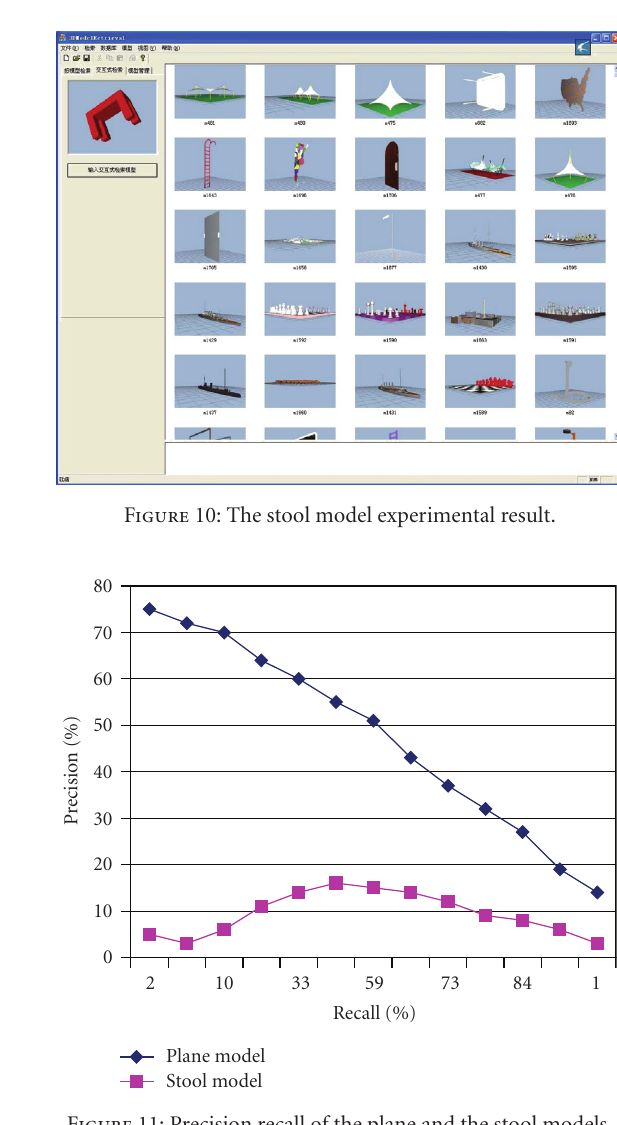
Figure 11: Precision recall of the plane and the stool